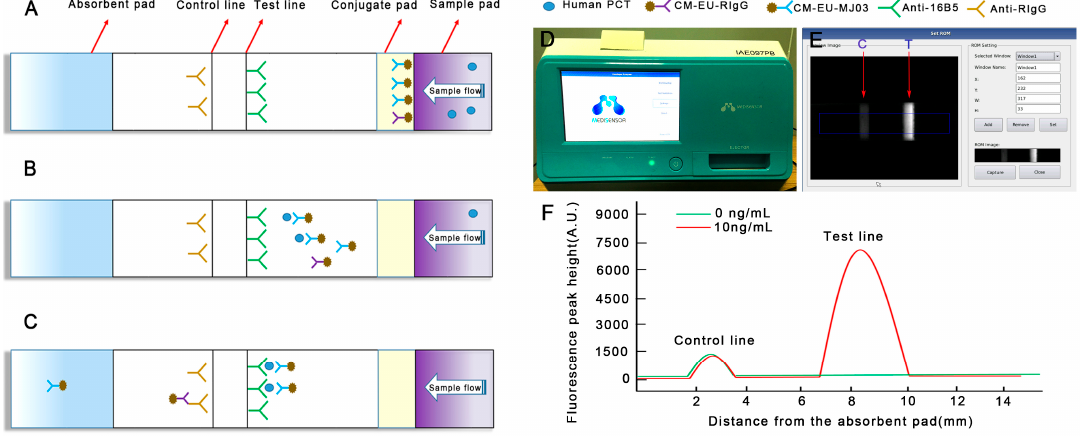
Figure 1. Schematic illustration of the assay procedure. ( A ) Sample containing procalcitonin (PCT) is applied to the sample pad; ( B ) PCT combines with CM-EU-MJ03 conjugates and migrates along the porous membrane by capillary action; ( C ) The formed complexes continue to migrate along the membrane and PCTs are captured by 16B5 to form CM-EU-MJ03-Ag-16B5 complexes on the test line. CM-EU-RIgG migrates continually to the control line, and is captured by anti-RIgG. The excess fluorescent microsphere continues to migrate toward the absorption pad; ( D ) The portable, small signal-acquisition device; ( E ) The preview images for “Rom setting” are selected; ( F ) The fluorescence peak height is measured by the reader.